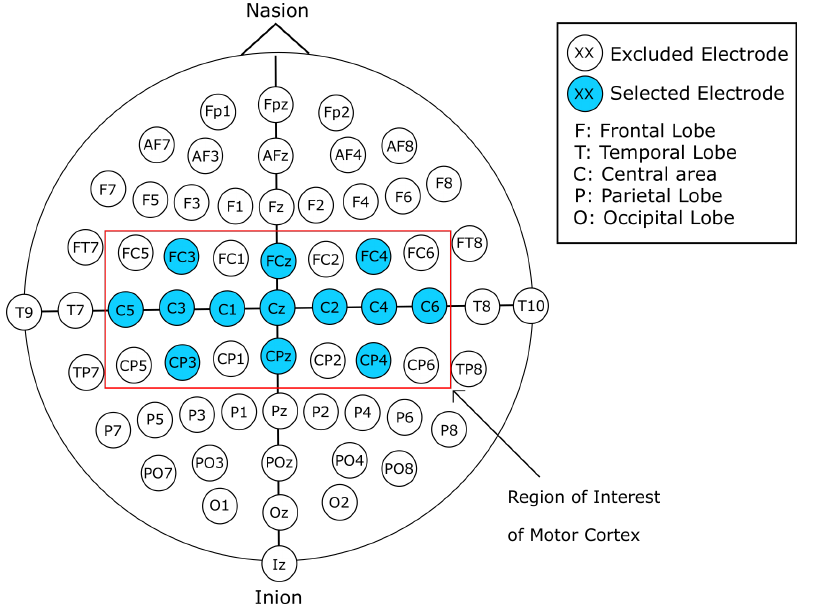
Figure 6. Cross-channel electrodes (blue highlight) employed for the second variant of the vertically stacked